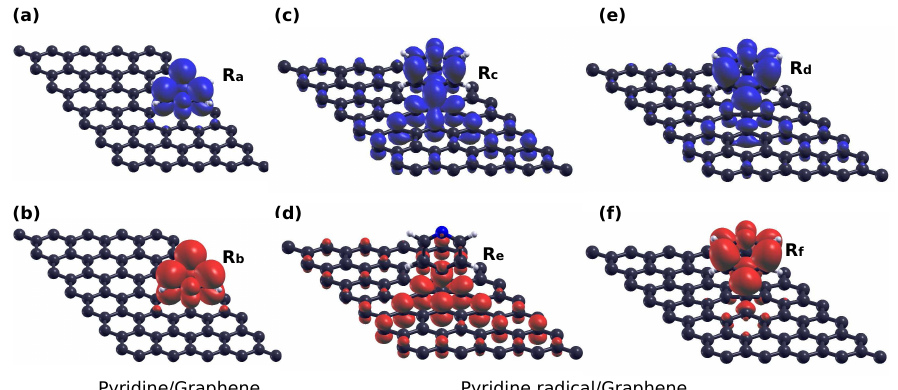
Figure 6. Local density of states integrated in energy (Integrated Local Densities Of States (ILDOS)) over the energy intervals marked by arrows in Figure 5e,f. ( a , b ) for pyridine/graphene, around the molecular LUMO for the ( a ) spin-majority and ( b ) spin-minority channels; ( c , d ) the mid-gap/LUMO hybrid states in the spin-majority channel for pyridine radical/graphene and ( e , f ) the spin-minority mid-gap and LUMO